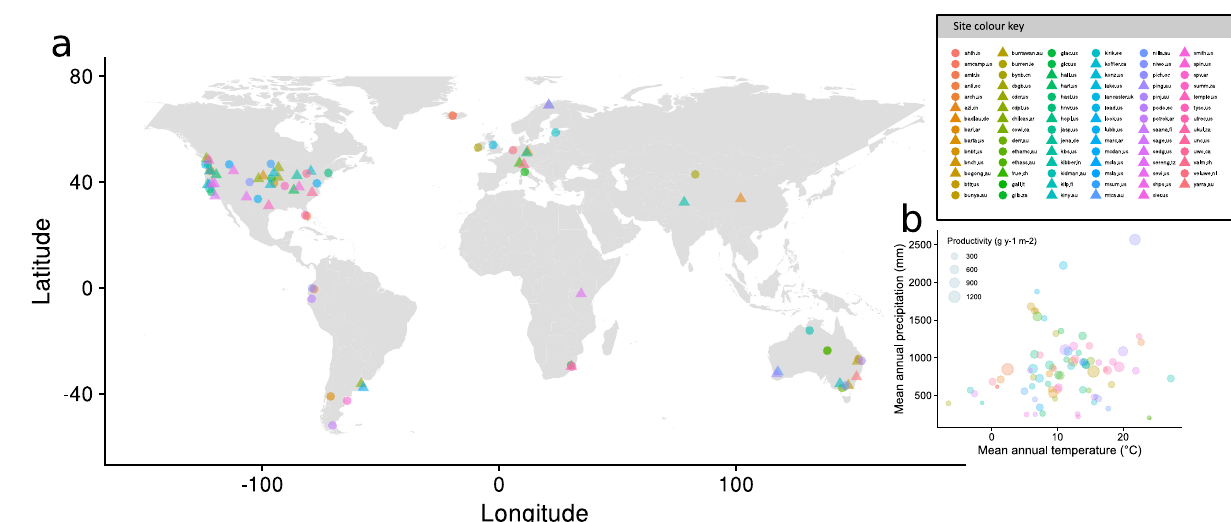
Fig. 2 | Geographic and climatic distribution of grassland sites. a Global map showingthelocationsofthe83grasslandsitesincludedinthisstudy.Allsiteswere used to analyze diversity – variability relationships under ambient spatial environ- mental heterogeneity (pre-treatment conditions). Triangles denote the 42 sites that implemented the experimental protocol used to evaluate the effect of